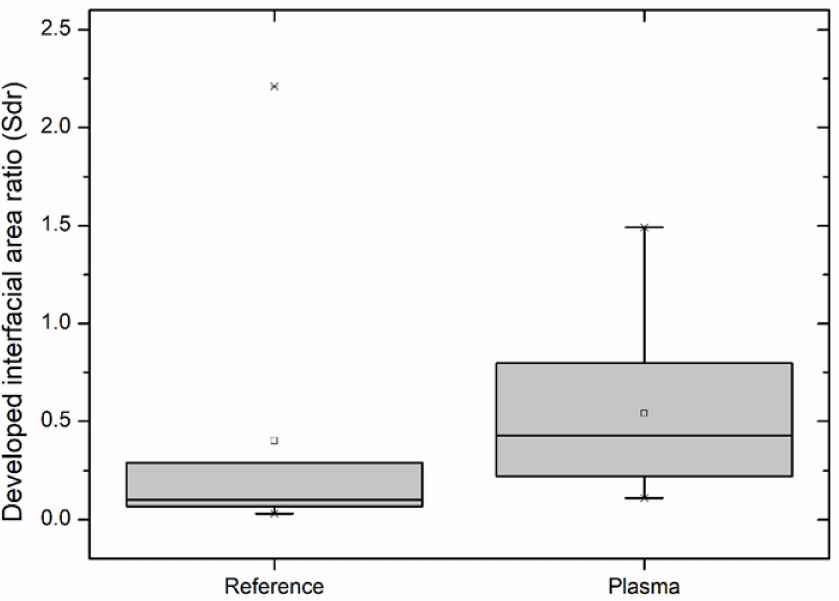
Figure 4. Developed interfacial area ratio (Sdr) of references and plasma-treated PLA WPC specimens calculated according to DIN EN ISO 25178 (2012)